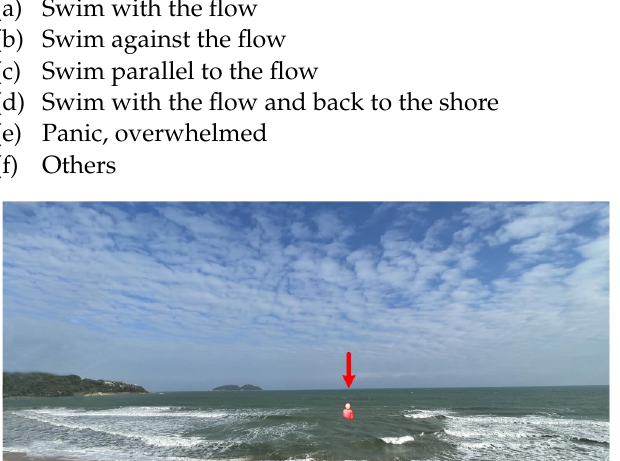
Figure A2. set of beach situ images of Hainan Island, South China. ( A ) and ( B ) without rips, ( C ) and ( D ) with rips. Figure A2. Set of beach situ images of Hainan Island, South China. ( A , B ) without rips, ( C , D ) with rips. Q14. If you were caught in the rip current, the red mark indicated your location (Figure A3), which direction would you choose to swim in? (If the respondents select (c) or (d), the judgment is “correct”. If other options are selected, the judgment is “incorrect”).